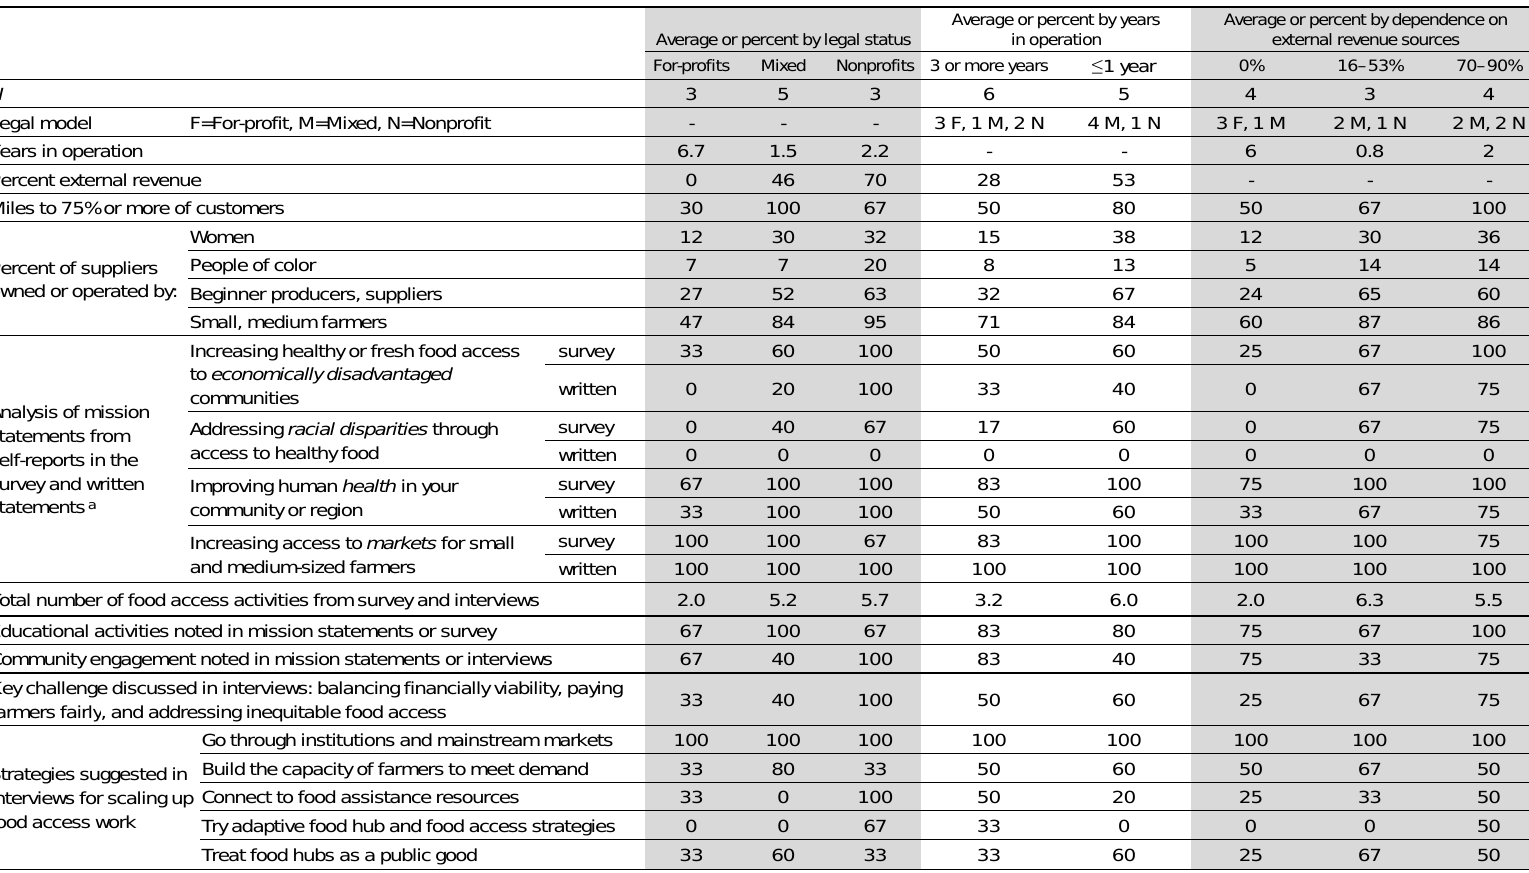
Table 2. Food Hub Characteristics, Missions, and Views on Challenges and Strategies for Scaling Up Food Access Work Compared Across Groupings of Hubs by Legal Status, Years in Operation, and Percent of Revenue from External